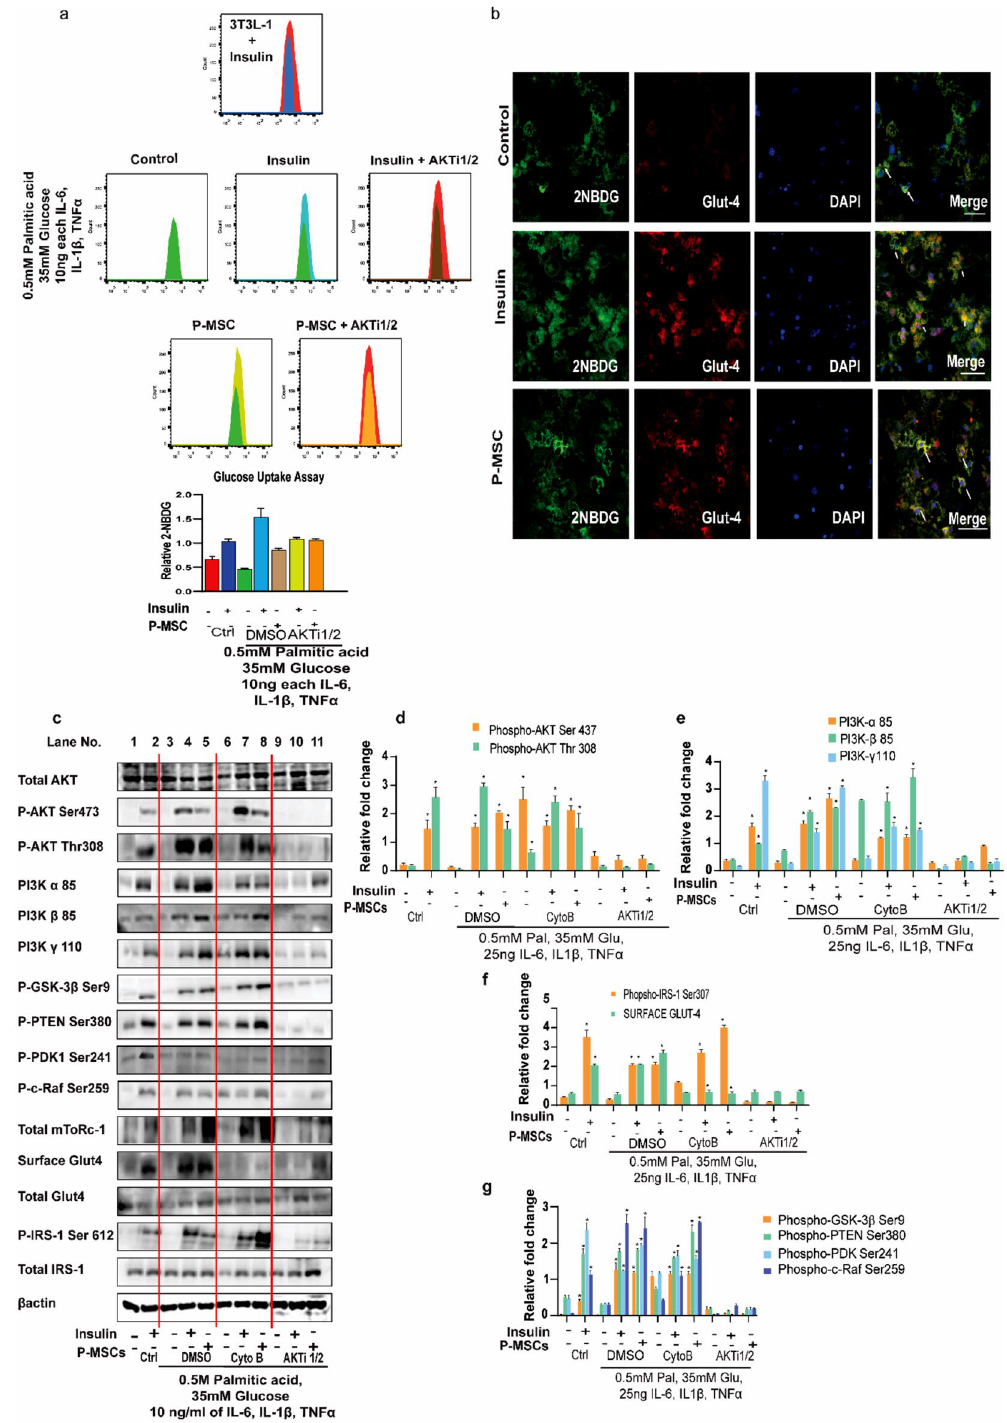
Figure 5. P-MSCs enhance the adipocyte glucose uptake and surface Glut4 translocation in adipocytes in a PI3K-AKT-dependent manner under obesogenic milieu. ( a ) FACS analysis of 3T3L-1 cells that are differentiated into adipocytes and co-cultured with human P-MSCs in the obesogenic milieu. Adipocytes were treated with AKT inhibitor (30 µM) for 30 min at the end of the co-culture. ( b ) Representative confocal images showing the co-localization of 2-NBDG and Glut4 in 3T3L-1 cells that were pre-differentiated into adipocytes and either stimulated with insulin (100 nM) for 20 min or co-cultured with human P-MSCs for 24 h. ( c ) Western blot images of the relative protein expression from the 3T3L-1 cells that were pre-differentiated into adipocytes and either stimulated with insulin or co-cultured with human P-MSCs, in the obesogenic milieu, as indicated. The cells were also treated with either AKT inhibitor (30 µM) for 30 min or with Cytochalasin B (25 µM) for 20 min to block the PI3K-Akt pathway or block the Glut4 surface translocation. ( d – g ) The relative levels of phospho-proteins and surface proteins for Glut4, compared to the respective total proteins, are also shown next to the western blots in the form of a bar diagram. Blots are representative of four independent experiments. Statistical analyses were performed between treated and untreated groups using two-way ANOVA (*p < 0.05, **p < 0.01). Error bars show one standard deviation from the